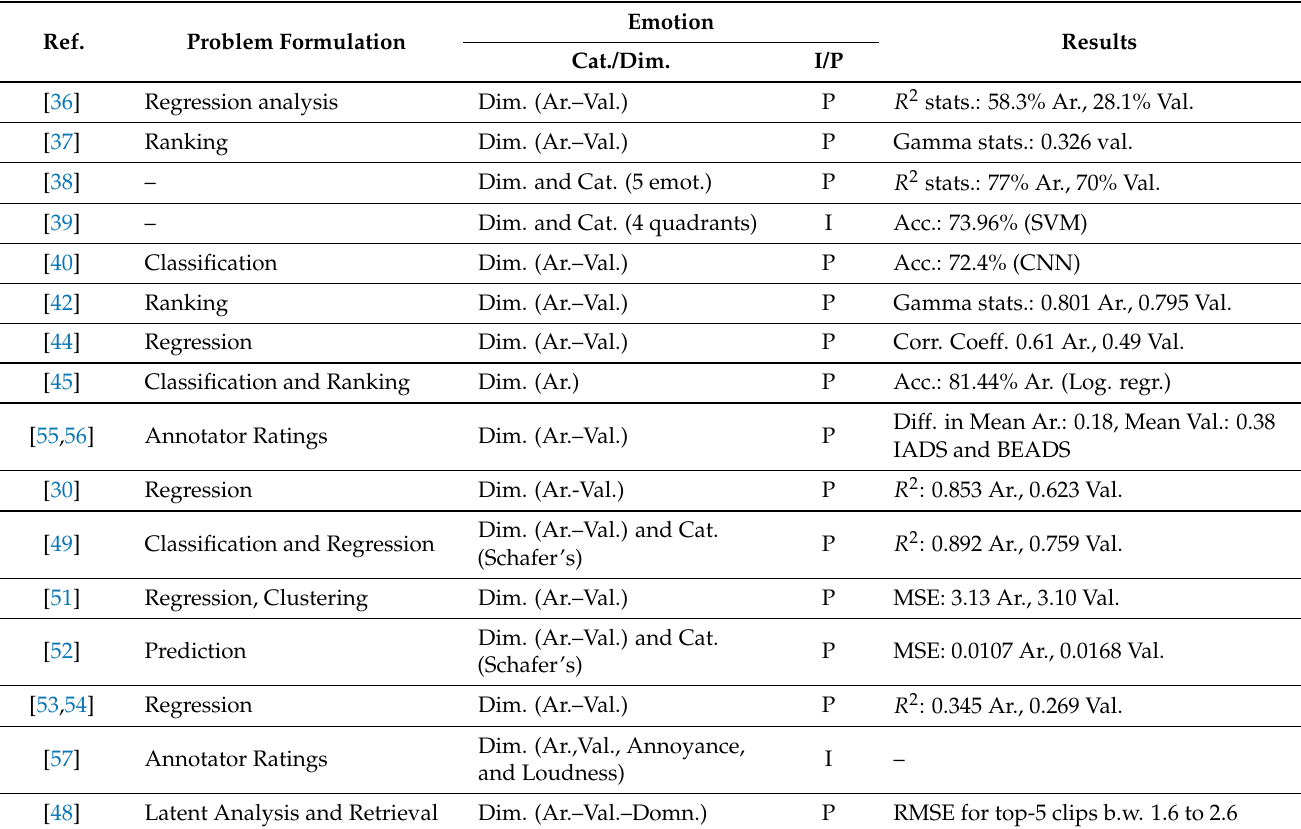
Table 1. Summary of emotion recognition in the